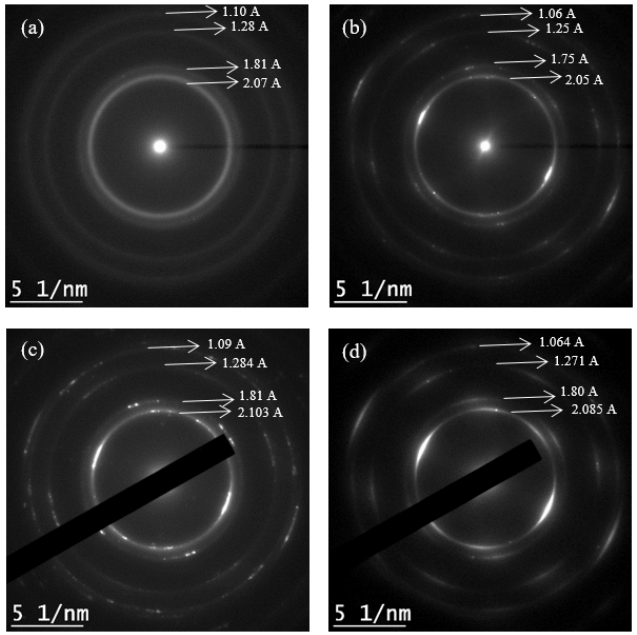
Figure 14. SAED patterns from DC electrodeposited NiW ( a ); NiW–SiC ( b ); NiW-hBN ( c ); NiW-hBN-SiC ( d ).